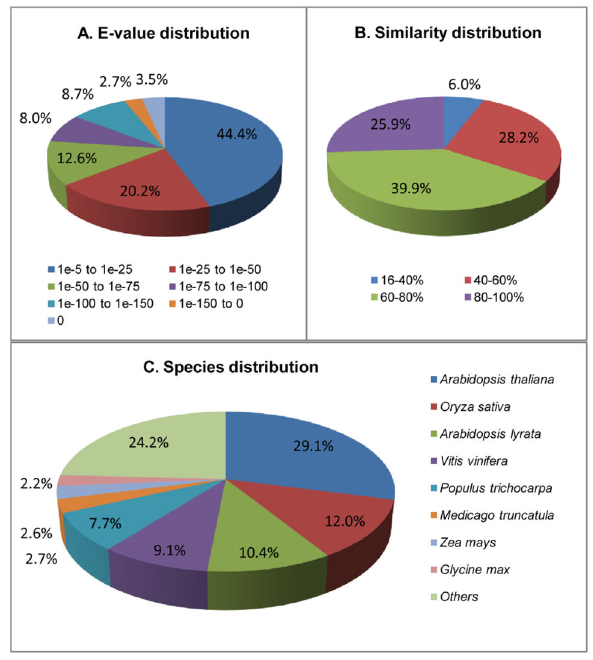
Figure 2. Characteristics of Blast homology search of unigenes against the NR database. (A) E-value distribution of the best matches for unigenes (E-value ≤ 1.0e-5). (B) Similarity distribution of the top BLAST matches for unigenes.